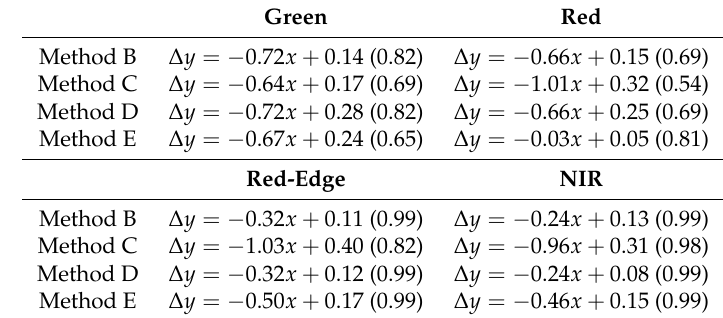
Table 6. Linear relationships describing measured reflectance deviance to true reflectance values for each multispectral band and radiometric calibration method. Model adjusted R 2 values were provided in